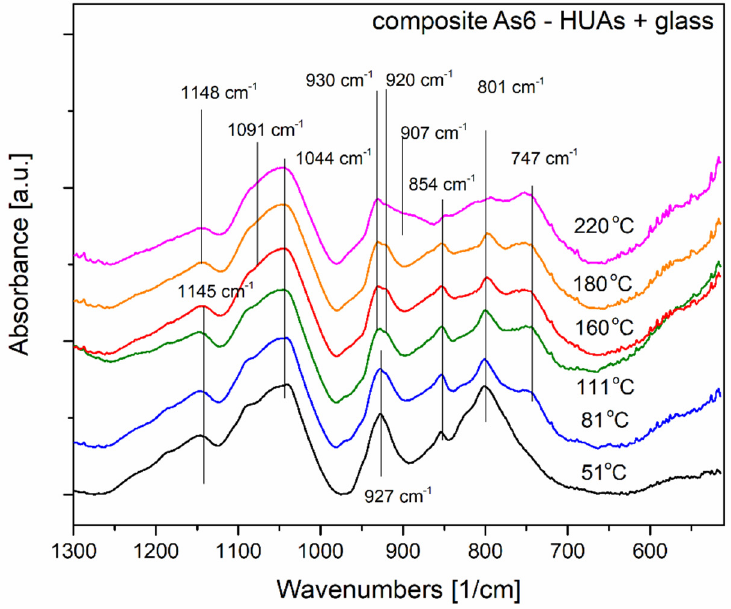
Figure 12. FTIR-ATR spectra of As6 composite samples (40% Gm + 60% HUAs) at elevated temperatures. The prominent maxima positions were marked, and the spectra were normed and shifted for clarity.